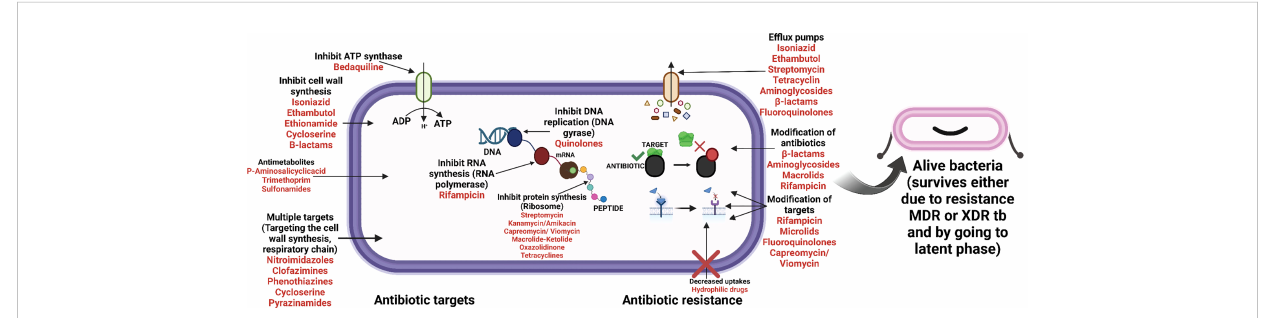
FIGURE 2 Upregulation of genes, playing vital role in helping bacteria to move to latent phase (post VC administration).